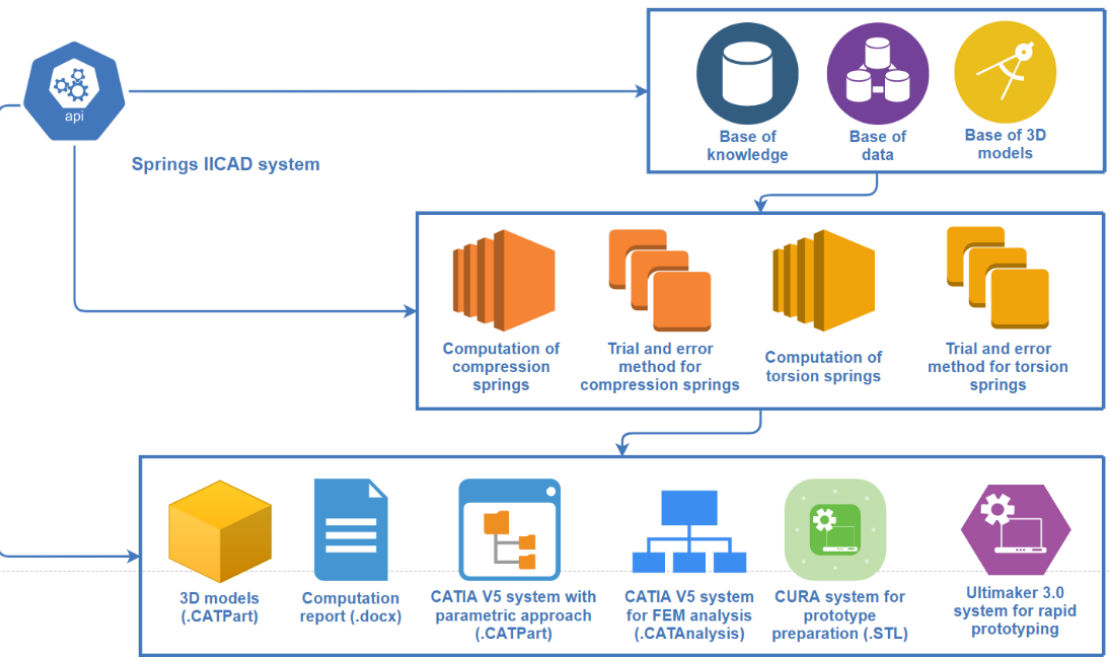
Figure 2. Springs IICAD system architecture.